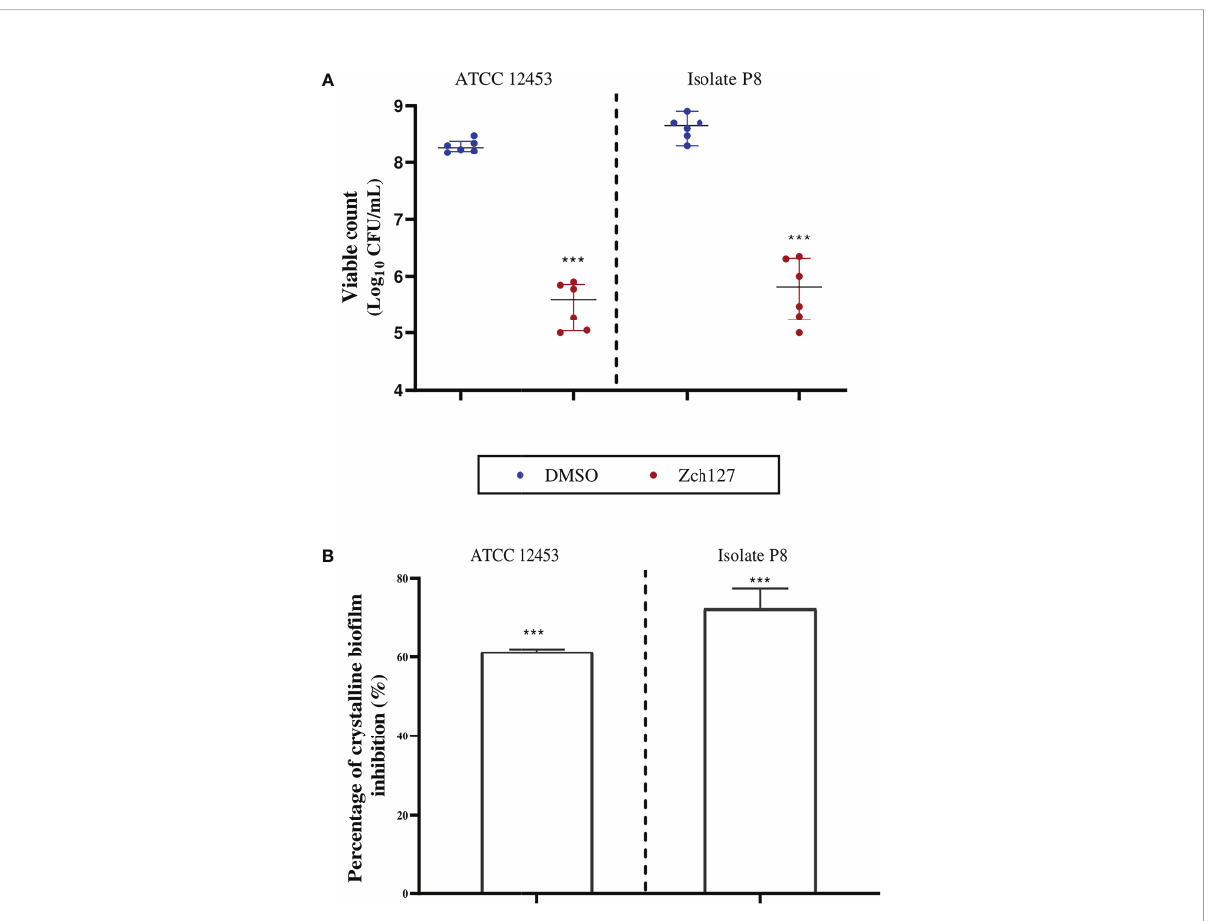
FIGURE 1 Indole impregnated silicone Foley catheter inhibit the bio fi lm formation by Proteus mirabilis . Quanti fi cation of the reduction in P. mirabilis crystalline bio fi lm on indole extract (Zch127) impregnated catheter compared to DMSO control, where (A) Reduction in adhered viable bacterial cells of P. mirabilis ATCC12453, and isolate P8 measured by drop plate method after 24 h of incubation, data are represented as median with interquartile range and (B) Reduction in bio fi lm biomass using crystal violet assay, data represents the mean of at least 3 biological replica, and error bars show standard deviation. Statistical difference was determined by student ’ s t-test, where statistical signi fi cance is represented by *** p <